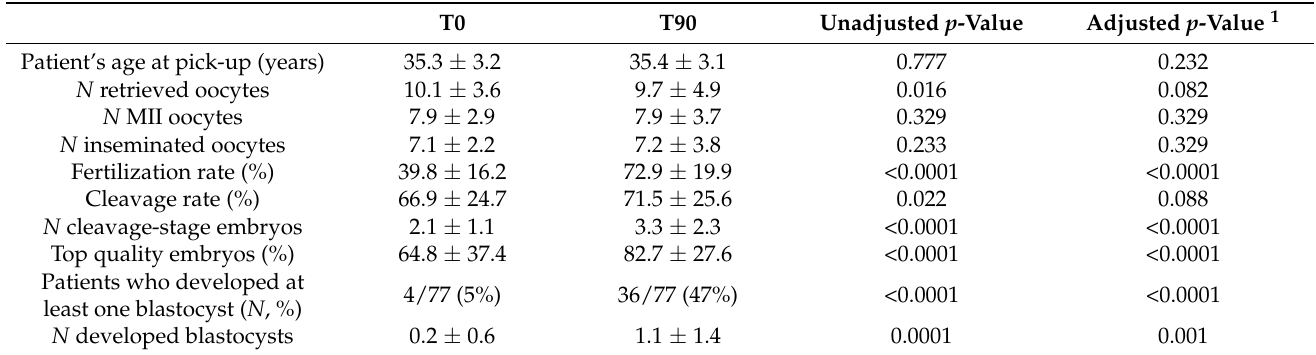
Table 3. Embryological outcomes of T0 and T90